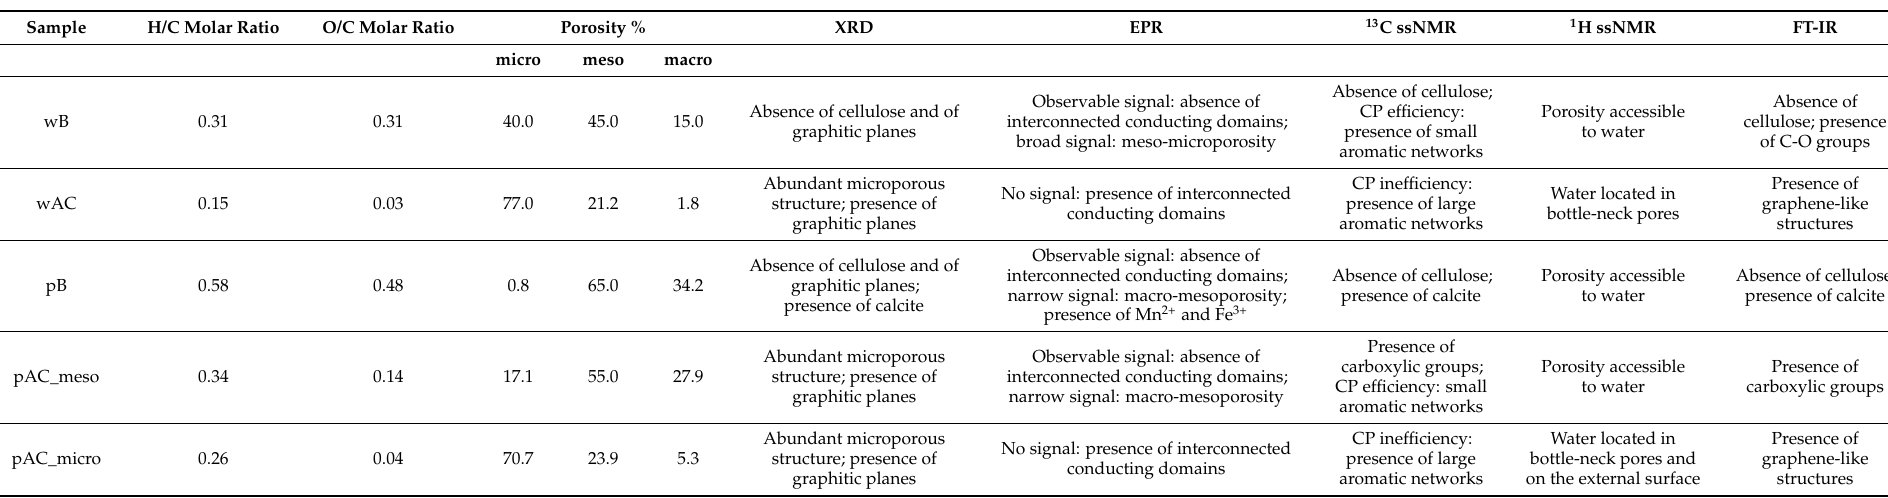
Table 3. Most relevant structural information emerging from each characterization technique for the samples under